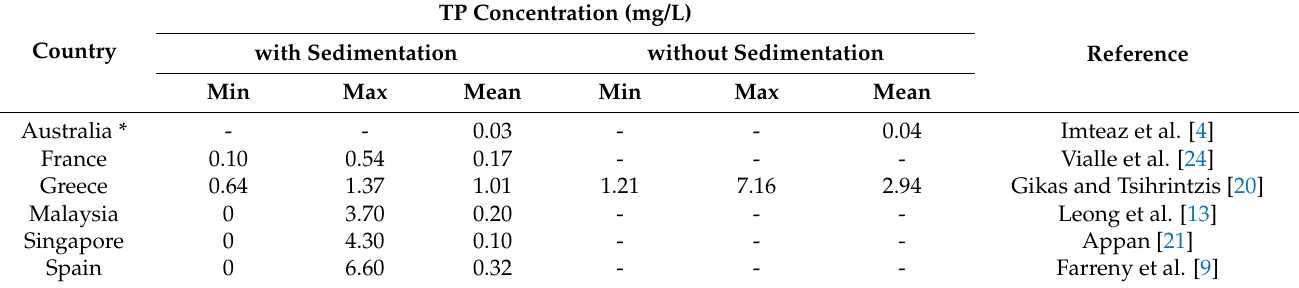
Table 2. Measurements on TP